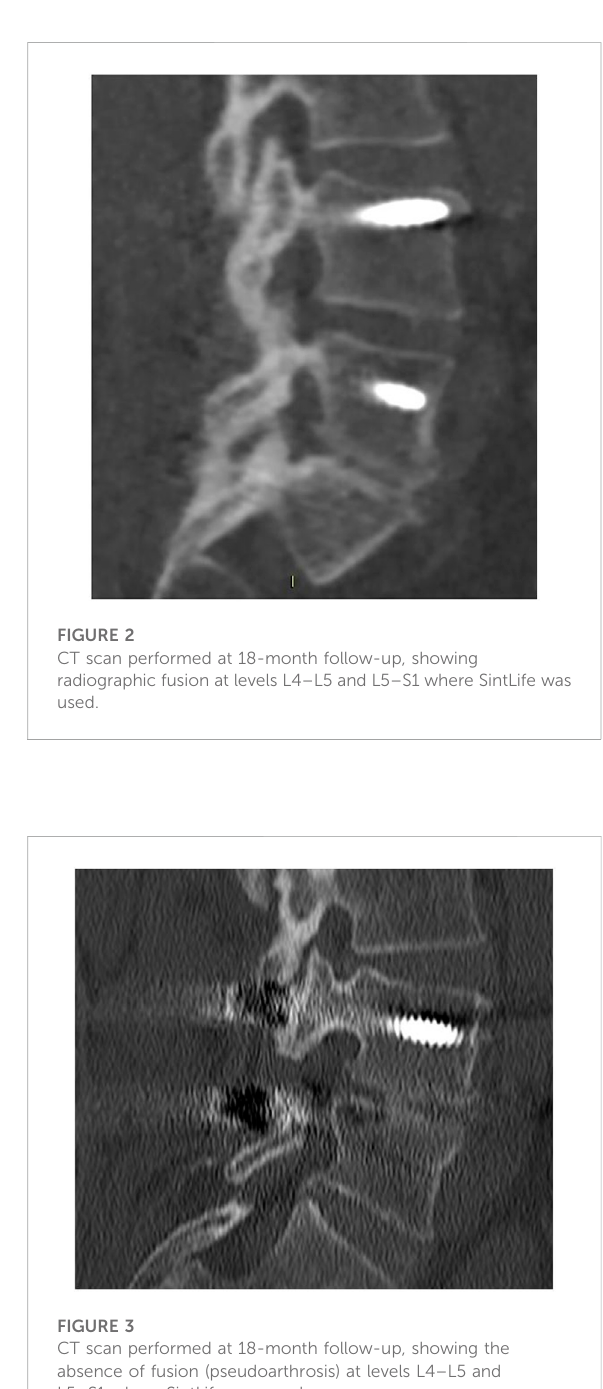
con fi rmed by quanti fi cation of the structural homogeneity of the bone graft area (ROI) (data not shown). Two cases of spinal arthrodesis with SintLife are reported in Figure 2 and Figure 3. The fi rst case was a 46-year-old female affected by degenerative disc disease L4 – L5 and L5 – S1 and treated with